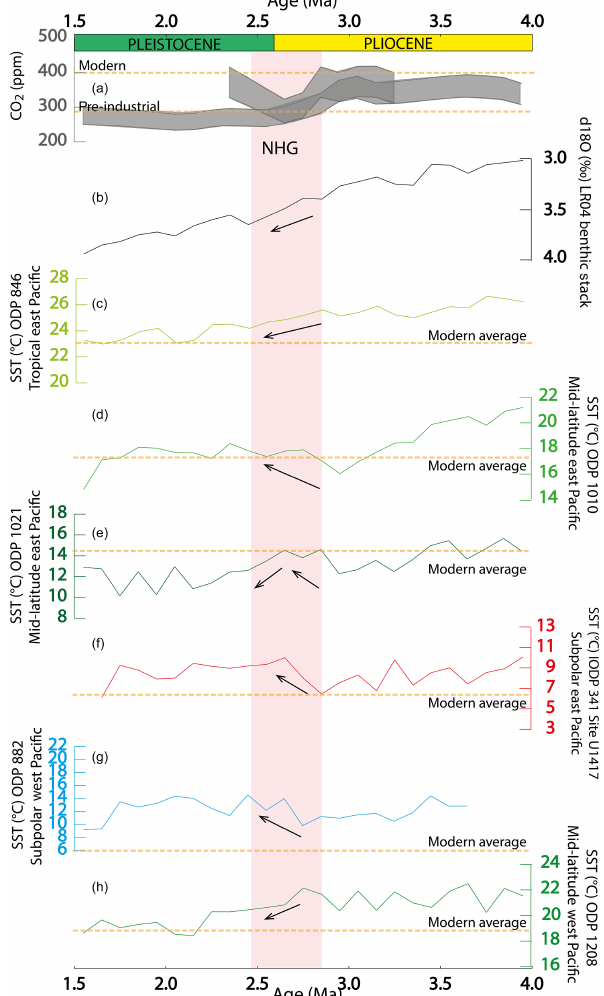
Figure 3. Pliocene–Pleistocene SST across the North Pacific. (a) Alkenone δ 13 C atmospheric CO 2 upper- and lower-end (ppm) estimates at Site ODP 999A (Seki et al., 2010b, revised in Foster et al., 2017) (4.0–1.5Ma) and marine δ 11 B atmospheric CO 2 upper- and lower-end (ppm) estimates at Site ODP 999 (2.3–3.2Ma) (Martínez-Botí et al., 2015, revised in Foster et al., 2017). (b) δ 18 O (‰) LR04 benthic stack (Lisiecki and Raymo, 2005). Alkenone SST ( ◦ C) from (c) ODP Site 846 (Herbert et al., 2017), (d) Site 1010 (Herbert et al., 2018a), (e) Site 1021 (Herbert et al., 2018b), (f) IODP Expedition 341 Site U1417 (Sánchez-Montes et al., 2019), (g) ODP Site 882 (Martínez-García et al., 2010b), and (h) ODP Site 1208 (Herbert et al., 2018c). The SST records are arranged from top to bottom following an anticlockwise direction from tropical east to subpolar east, subpolar west, and tropical west locations. Orange horizontal lines indicate reference levels of pre-industrial times and/or modern values for each of the records or sites (SSTs from NOAA WOA13, Boyer et al., 2013). Arrows indicate cooling or warming trends across the oNHG in the Pacific Ocean. All records are 1kyr linearly interpolated and 100kyr smoothed. Ages (Ma) have been determined through the calculation of the mean for each